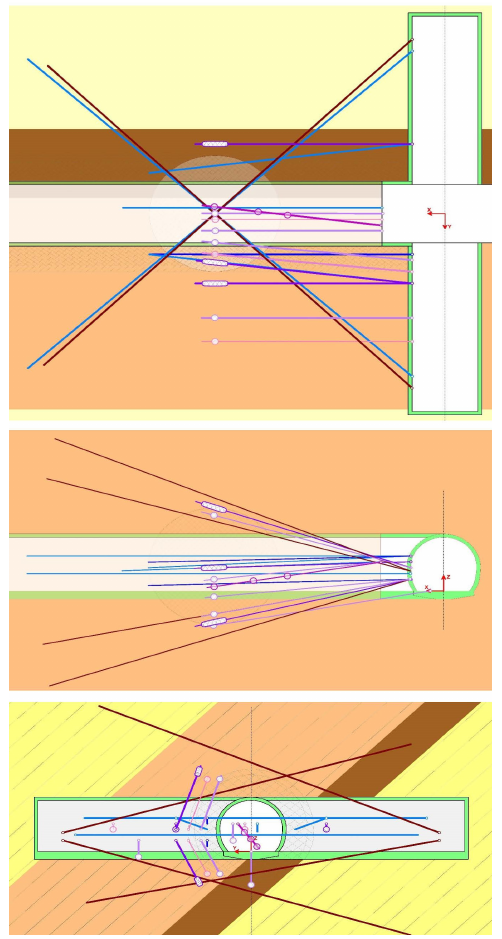
Figure 10. Location of the Mine-by Experiment MB-A and its instrumentation; brown lines, inclinometers for vertical deformation; blue lines, extensometers for horizontal deformation; pink lines, piezometers for pore pressure; purple lines, stress monitoring systems for stress